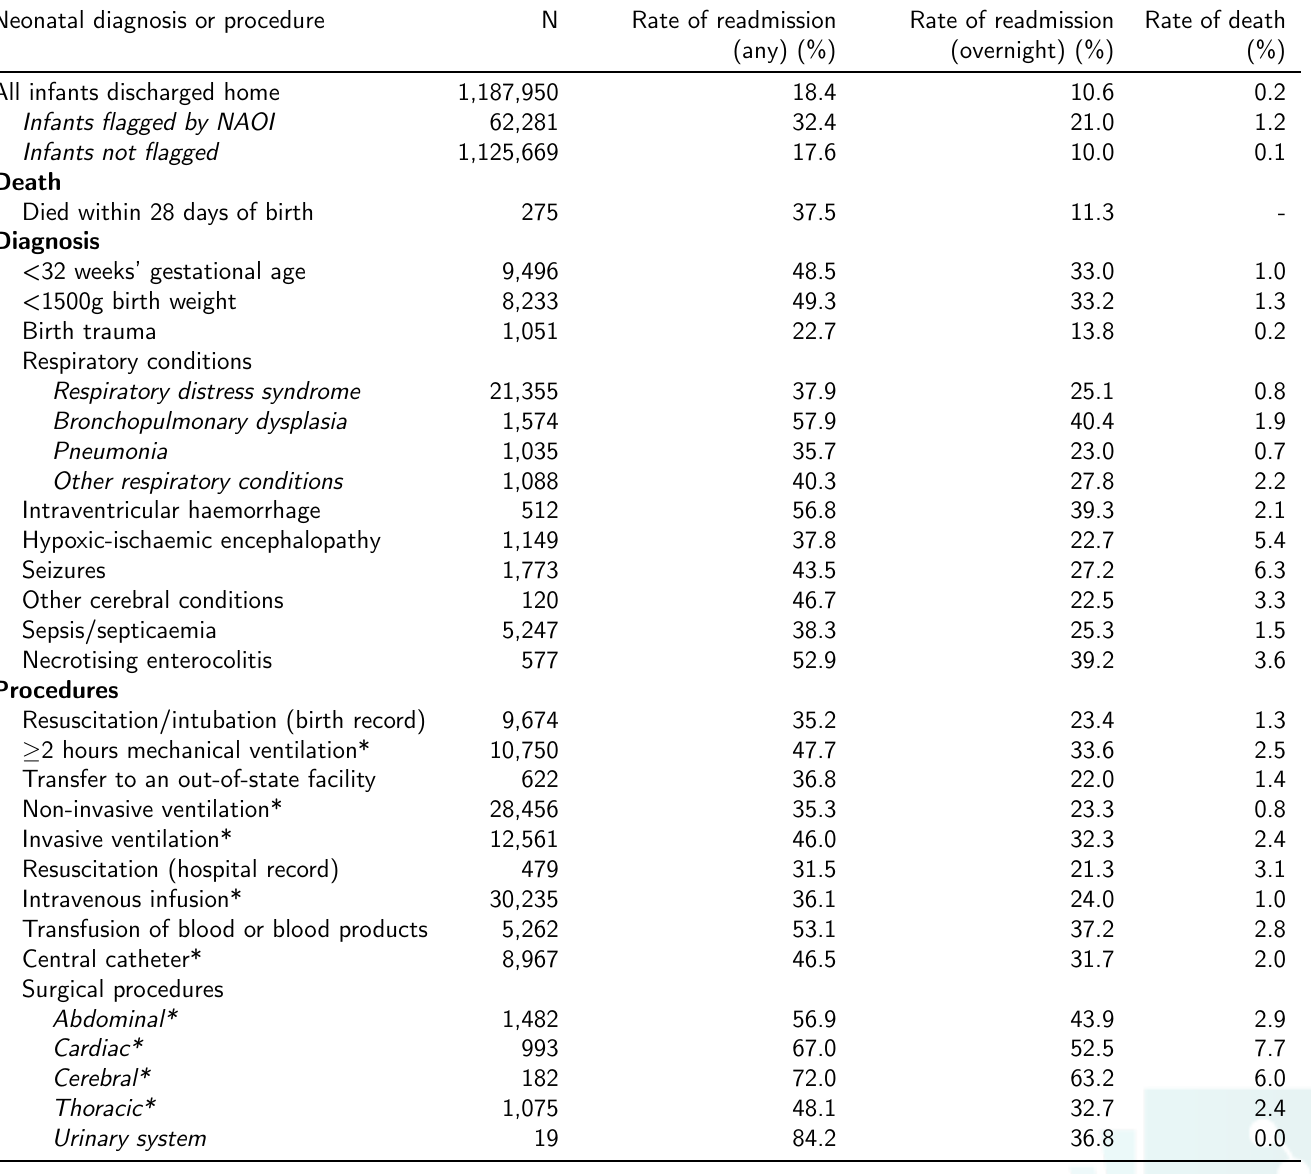
Table 4: Rates of hospital readmission or death among infants discharged home up until their first year, total and by components of the neonatal morbidity indicator